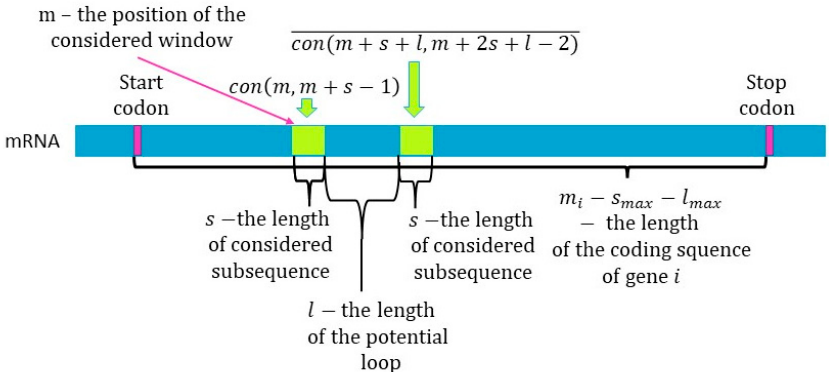
Figure Figure A1. The illustration of the analysis of local inverted repeats in a window 𝑚 ∈ [1,𝑚 (cid:3036) − 𝑠 (cid:3040)(cid:3028)(cid:3051) −𝑙 (cid:3040)(cid:3028)(cid:3051) ] described in Formulas (A7) and (A8).